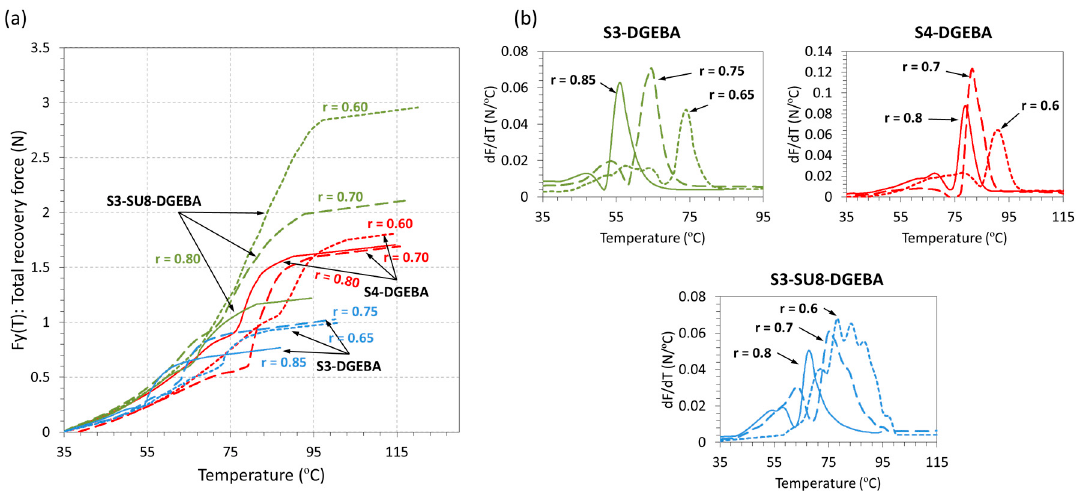
Figure 9. Shape-memory fully-constrained recovery experiments: ( a ) force generated as a function of the temperature; and ( b ) derivative of the force generated with respect to the temperature as a function of the temperature.